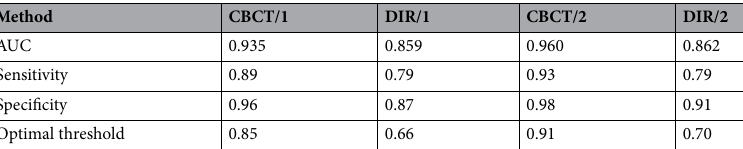
Table 3. Statistic results of the16 observers pooled for digital volume tomography (CBCT) and intraoral images (DIR), first trial (1st) and second trials (2nd), respectively (AUC = area under the curve; α = 5%, p < 0.001; Youden index).